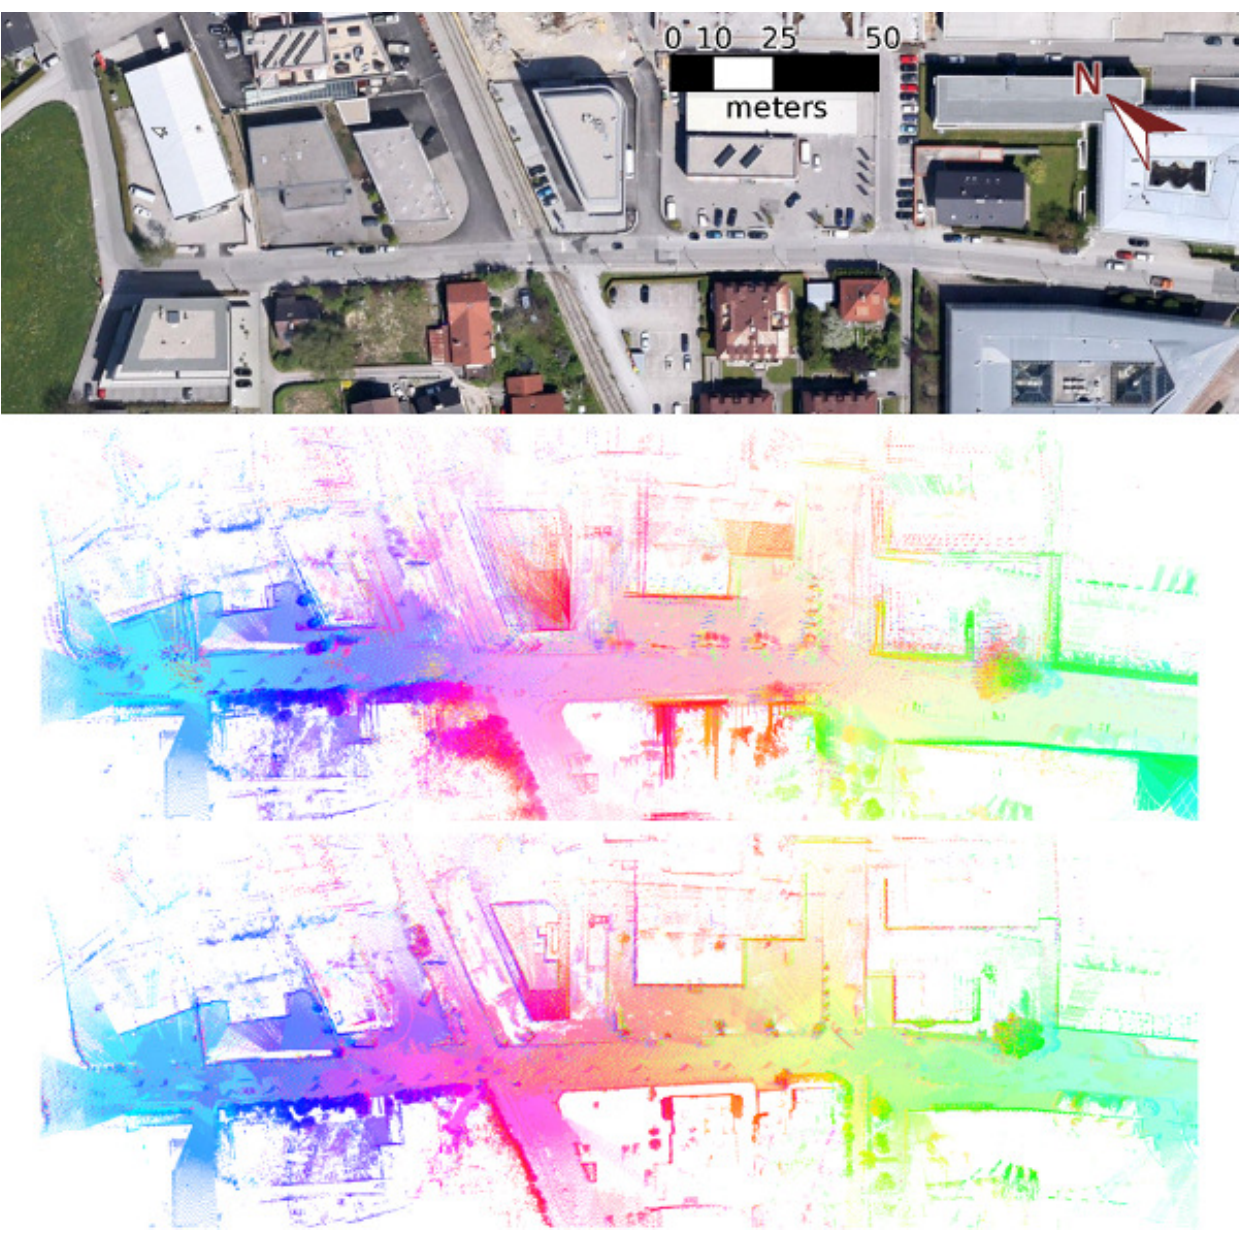
Figure 13. The Salzburg dataset provided by RIEGLLaser Measurement Systems GmbH. ( Top ) Aerial view on the region. Image courtesy of Aerodata International Surveys, Geoimage Austria and